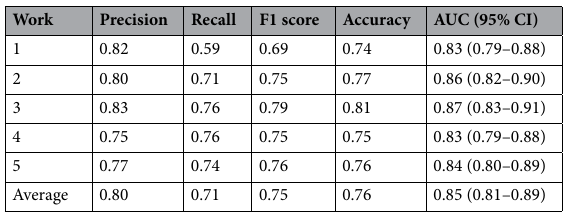
Table 4. Five-fold cross-validation in Trial 3.